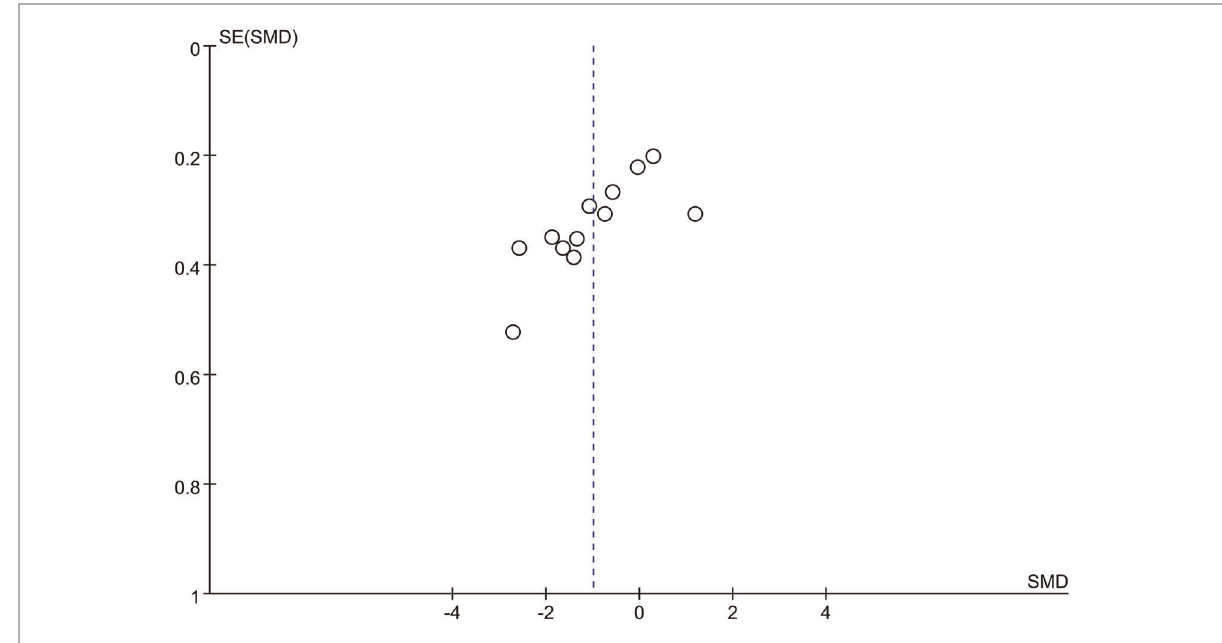
FIGURE 9 Funnel plot of evaluating publication